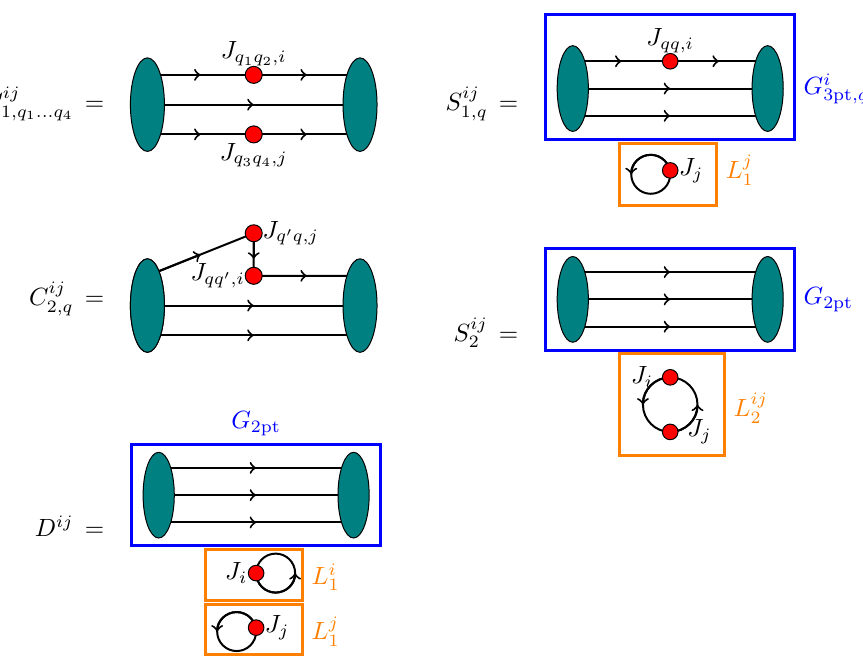
, C and S depend on the quark 1 2 1 , S and D we 1 2 and G (blue), as well 3pt 2pt